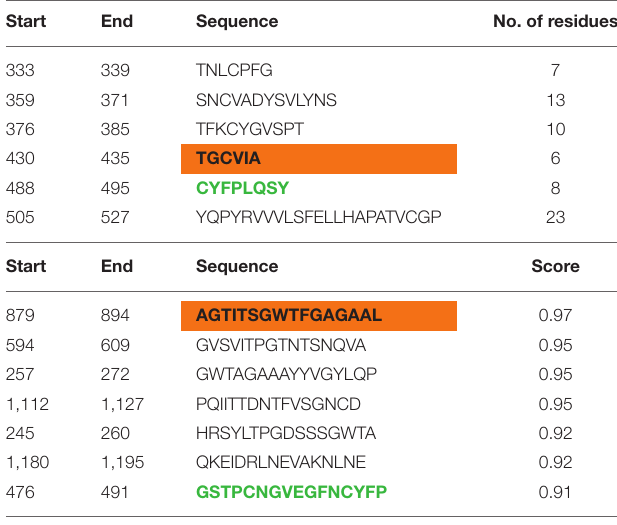
Orange color highlighted, and green color bolded sequences are predicted by two or three